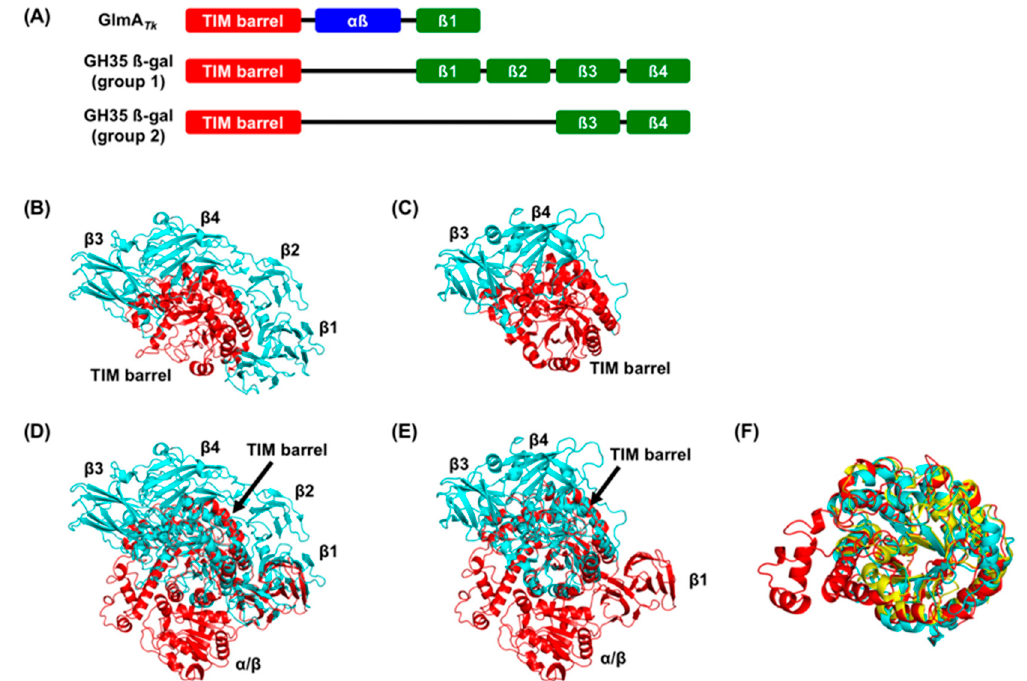
Figure 3. Structural comparison between GlmA Tk and GH35 β -galactosidases. Seven GH35 β -galactosidases were compared to GlmA Tk , but, for clarity, only the results of Tri- β -gal (PDB 3OGR) and Hs- β -gal (PDB 3THC) are shown as representatives of Group 1 and 2, respectively. ( A ) Schematic presentation of the domain organization of GlmA Tk , a Group 1 GH35 β -galactosidase, and Group 2 GH35 β -galactosidase; ( B ) The structure of Tri- β -gal (TIM-barrel: red, β 1–4: cyan); ( C ) The structure of Hs- β -gal (TIM-barrel: red, β 3 and β 4: cyan); ( D ) Superimposed models of GlmA Tk monomer structure (red) and Tri- β -gal (cyan); orientation, same as that in B; ( E ) Superimposed models of GlmA Tk monomer structure (red) and Hs- β -gal (cyan); orientation, same as that in C; ( F ) Superimposed models of the TIM-barrel domain (chain A) of GlmA Tk (red), Tri- β -gal (cyan), and Hs- β -gal (yellow).